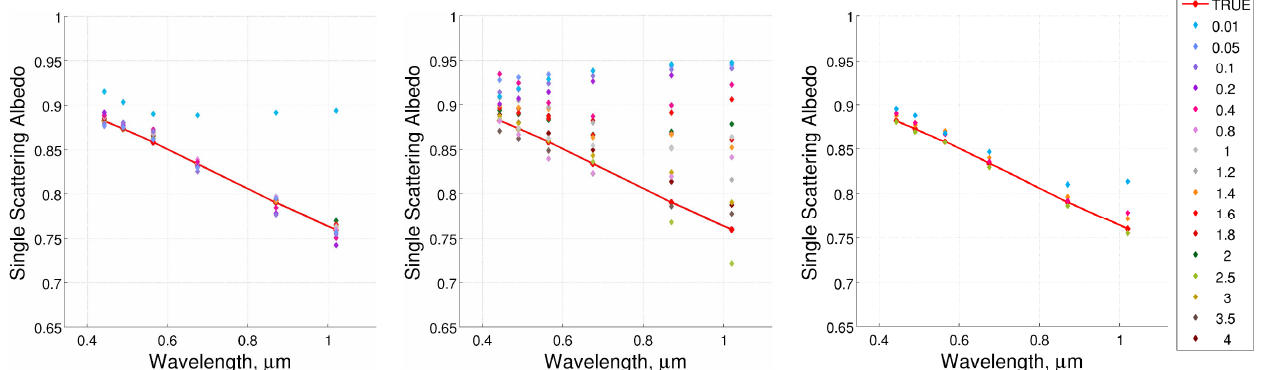
Fig. 10. Retrieval of biomass burning single scattering albedo over Mongu for 16 different aerosol loadings from τ (0.44µm)=0.01 to 4.0: (left panel) single-pixel retrieval with no noise added; (center panel) single-pixel retrieval with the random noise added; (right panel) multi-pixel retrieval with the random noise added.